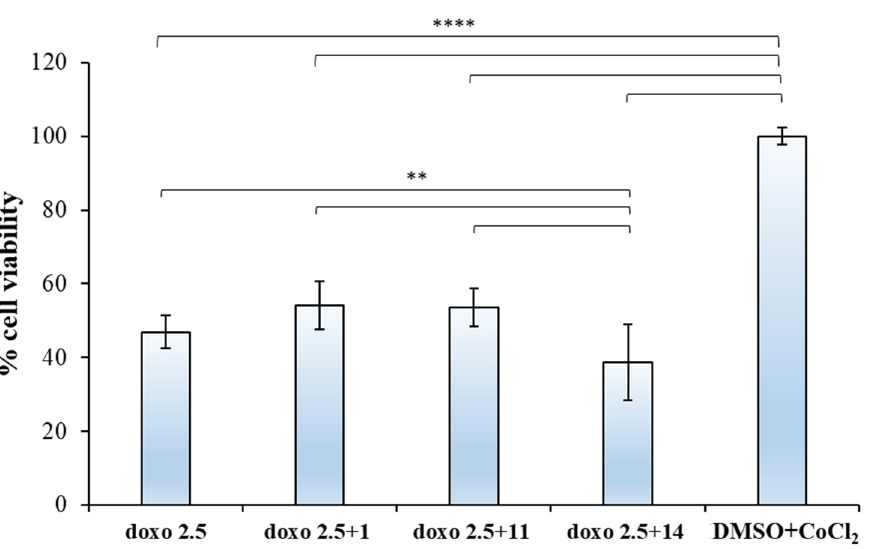
Figure 4. MTT assay on MCF7 cell line. Histogram represents the viability percentage of MCF7 cells exposed to doxorubicin 2.5 µM and to combinations of doxorubicin 2.5 µM with compounds 1 , 11 , and 14 , all administered at 100 µM for 72 h and under hypoxic conditions. Cell viability was measured by MTT assay and normalized to control cells treated with DMSO (0.1% as final concentration) + CoCl 2 100 µM. The most representative of three separate experiments is shown. Data are presented as the mean ± standard deviation. **** p < 0.0001; ** p <